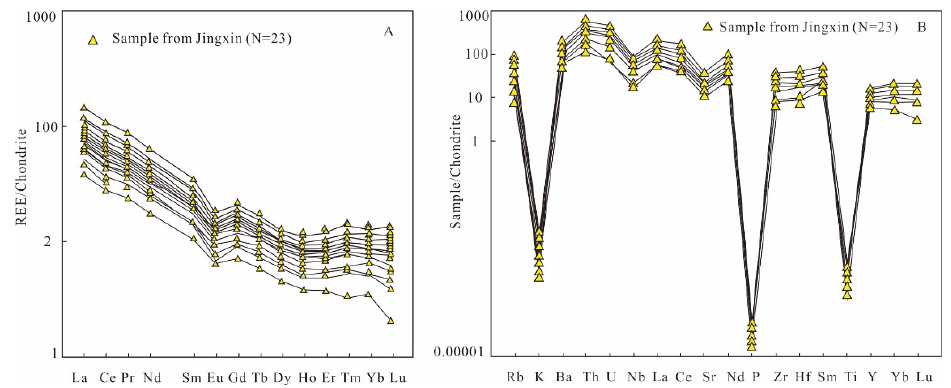
Figure 4 . ( A ) Chondrite-normalized rare earth element (REE) patterns of sandstones of the Jingxing Formation (after Taylor and McLennan 1985 [46]). ( B ) Chondrite-normalized trace element spider diagram of the sandstones of Jingxing Formation (after Taylor and McLennan 1985 [46]).